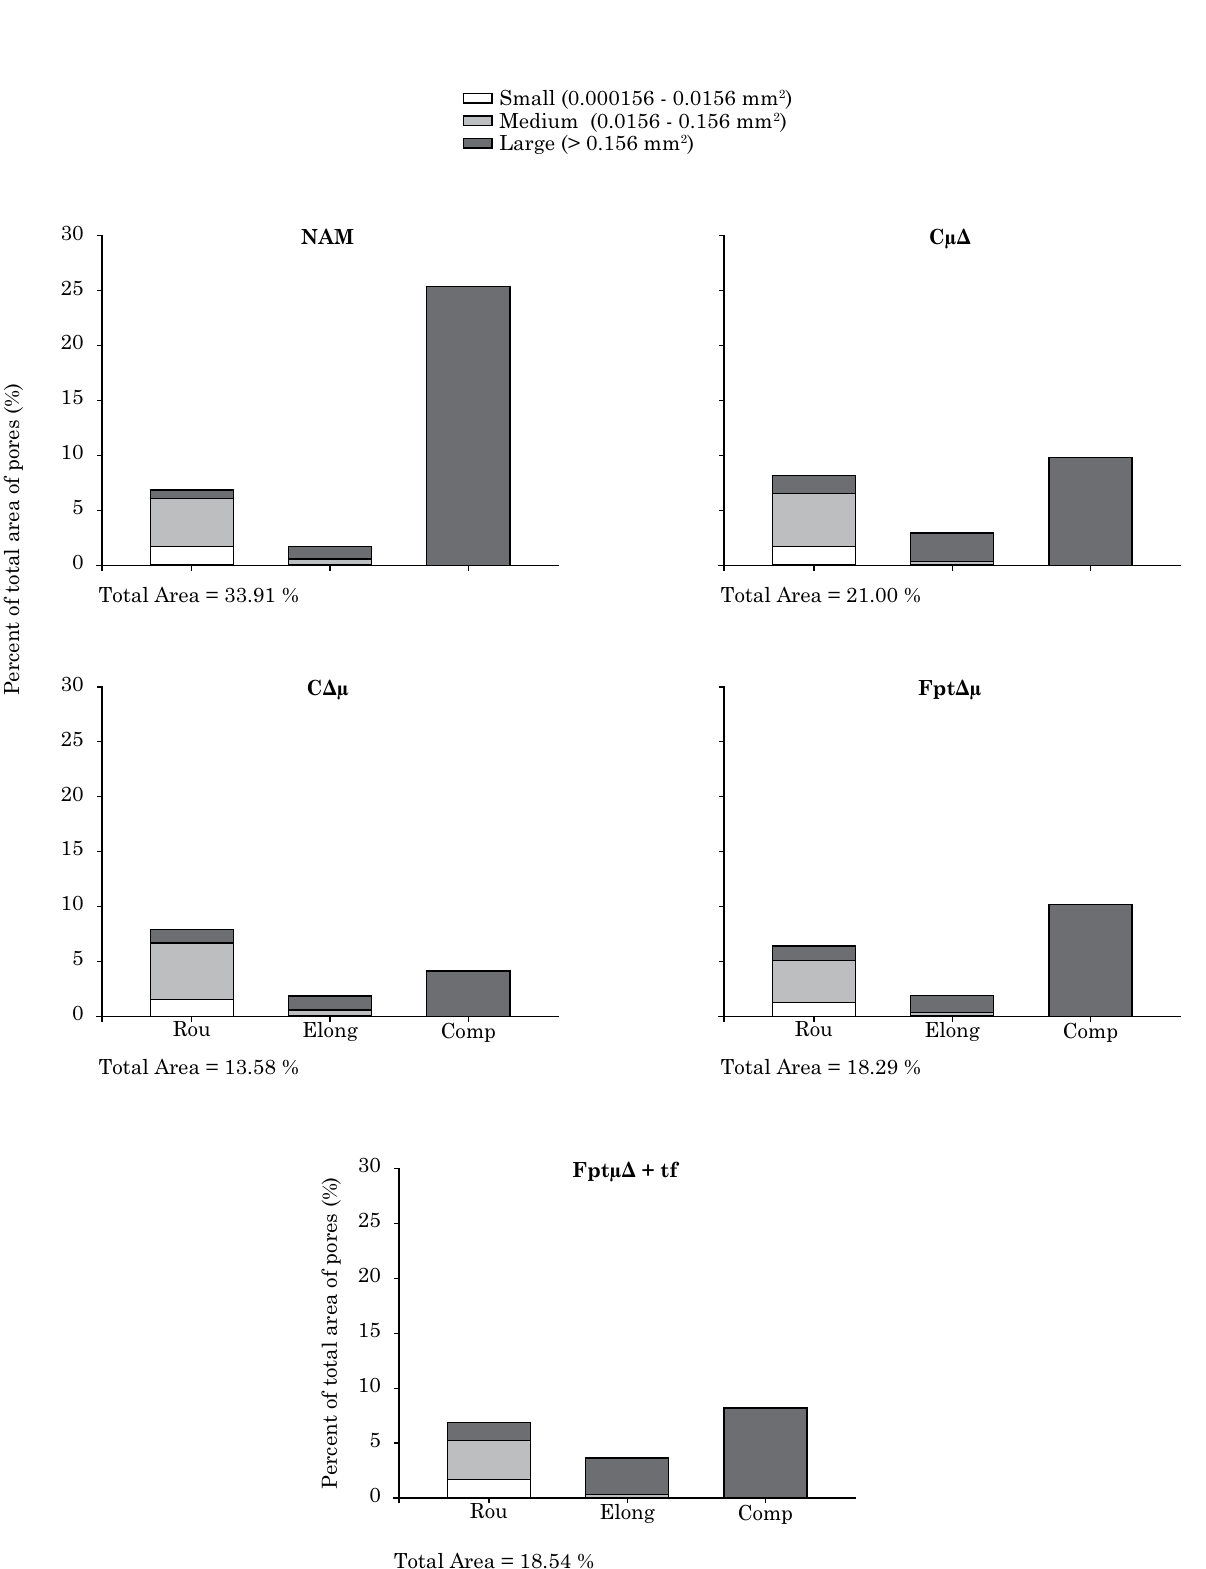
Figure 8. Distribution of the total area of pores according to shape and size of pores in the MHUs of the crop profile under Conventional System. Rou: rounded; Elong: elongated; Comp: complex. NAM: not altered by management; F or C: fragmented or continuous volumes of soil; ∆μ or μ∆: compact or porous clods, with aggregates that are very compact (∆), compact (∆μ) and in the process of compaction (μ∆); pt, mt, gt: small, medium, or large clods; and tf: fine